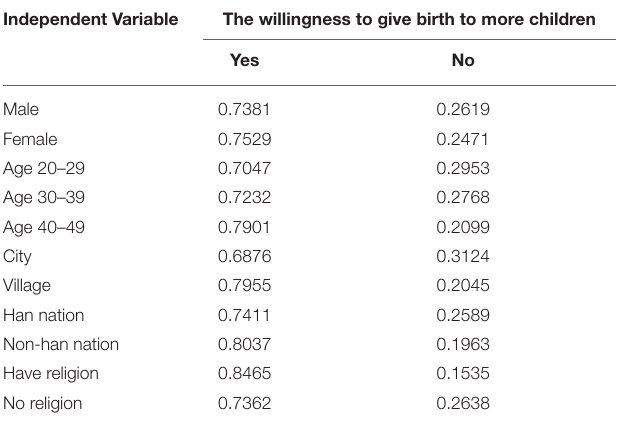
TABLE 3 | Descriptive statistics of the willingness to give birth to more children by classifying the sample. Independent Variable